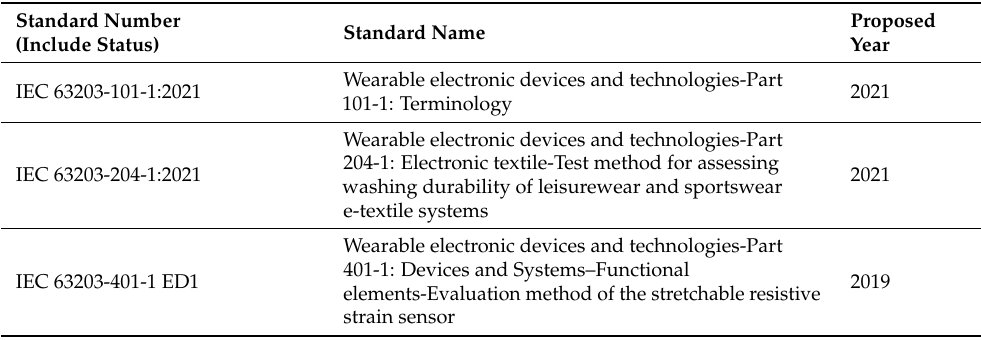
Table 1. Status of major international standards being established in TC124 related to wearable technology